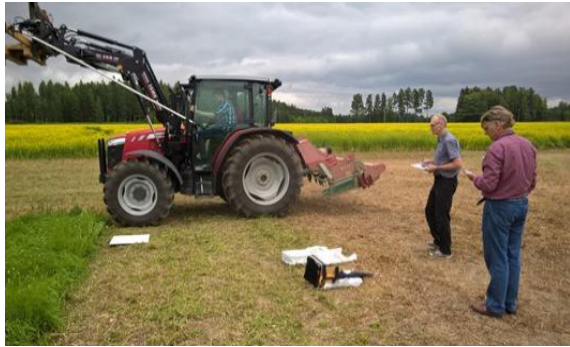
Figure 9 DroneKnowledge VIS-VNIR-SWIR hyperspectral imaging system mounted on the tractor at grass field in Jokioinen, Finland on 24.7.2017.